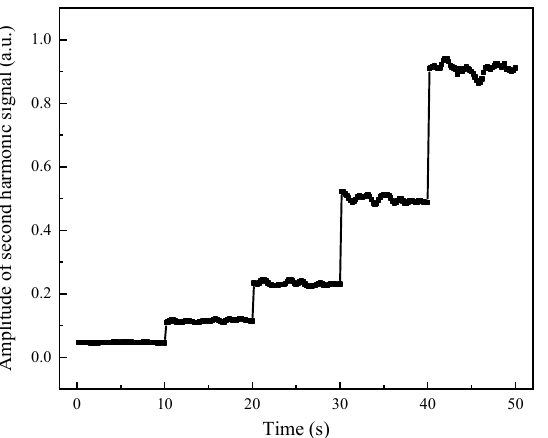
( b ) Figure 4. Detected result of CO with different concentrations in the gas chamber based on TDLAS: ( a ) waveforms of the second harmonic signal; and ( b ) amplitudes of the second harmonic signal. The scanning period of the laser modulation signal was 200 ms. By continually col- lecting the detection signal for 50 times, it was possible to achieve the stability of the gas detection result within 10 s. Figure 5 displayed the stability of the ASH for gases at various concentrations. The relative standard deviations of CO detection signals with concentra-